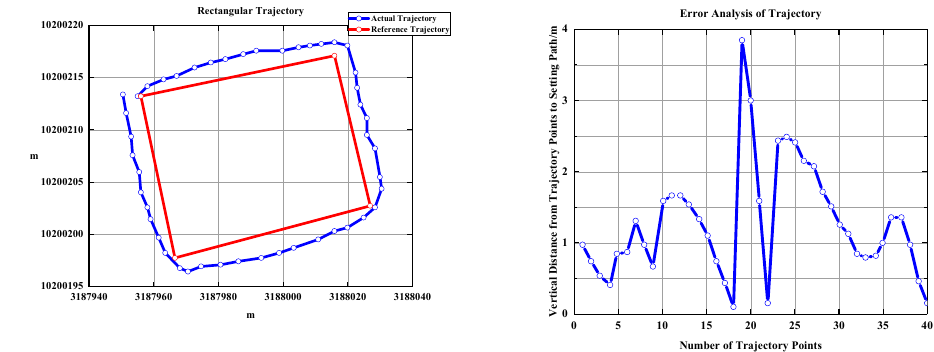
Figure 16. Square Path Test and Error Analysis (( a ): before improvement; ( b ): after improvement).